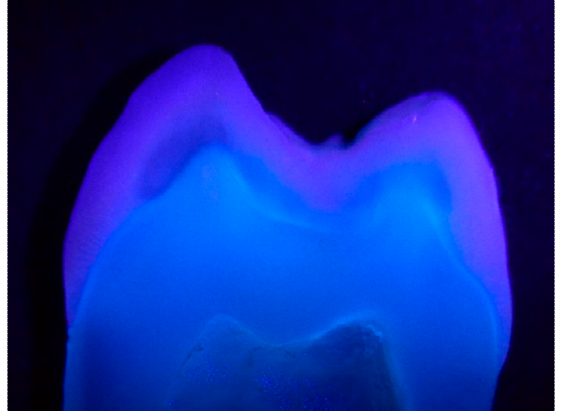
Figure 1. Fluorescence of a premolar slice (in 385 nm UV light). The digital equipment used was a DSLR camera (Nikon D3100, Nikon Corporation, Tokyo, Japan) equipped with a macro objective (Tamron 90 mm), ISO 200, f/22, exposure time: 1/200 s.